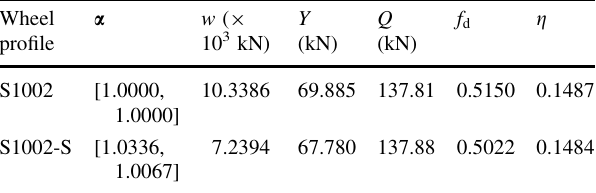
Table 3 Comparison of results calculated by